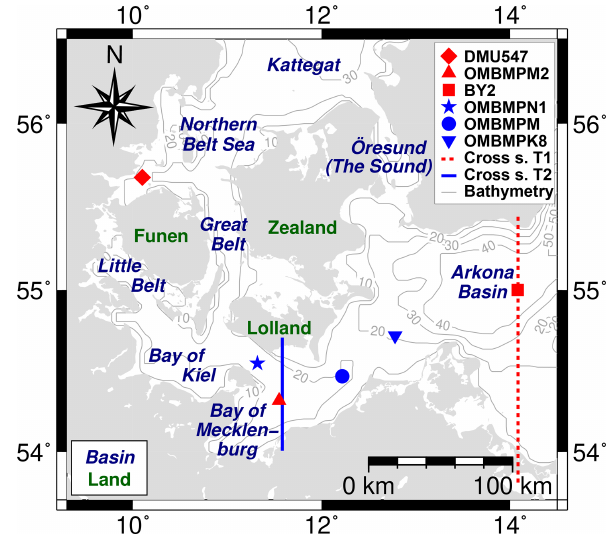
Figure 3. Study region, measurement stations, cross sections for evaluation, and geographic locations mentioned in this publication. Basins of the Baltic Sea and of the Kattegat are printed in navy blue italic font. Islands and peninsulas are printed in green. Measure- ment stations are indicated by symbols and colors as defined in the legend (top right). Cross sections for model evaluation are indicated by red dotted (T1) and blue solid lines (T2). Red stations and lines are considered in this paper (top three stations in the legend) and blue stations and lines in the Supplement (items four to six in the legend). The solid gray lines with numbers attached are isolines of the bathymetry. The numbers give the depth in